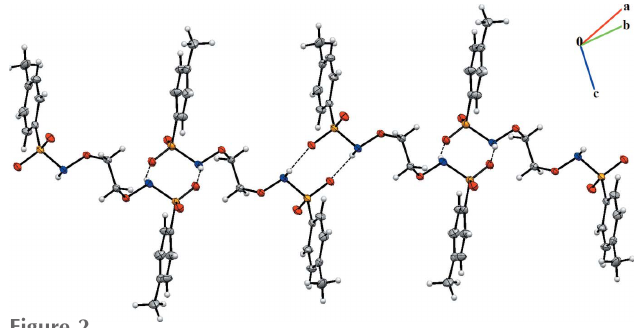
Figure 2 A view of the chain structure formed by N—H (cid:2)(cid:2)(cid:2) O hydrogen bonding.